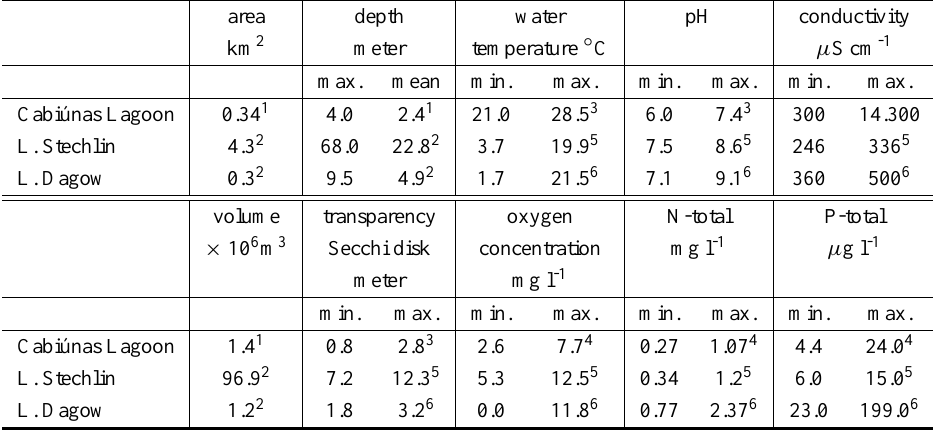
Morphological and limnological characteristics of Cabiúnas Lagoon, Lake Stechlin and Lake Dagow. area depth water pH conductivity km 2 meter temperature ◦ C µ S cm -1 max. mean min.